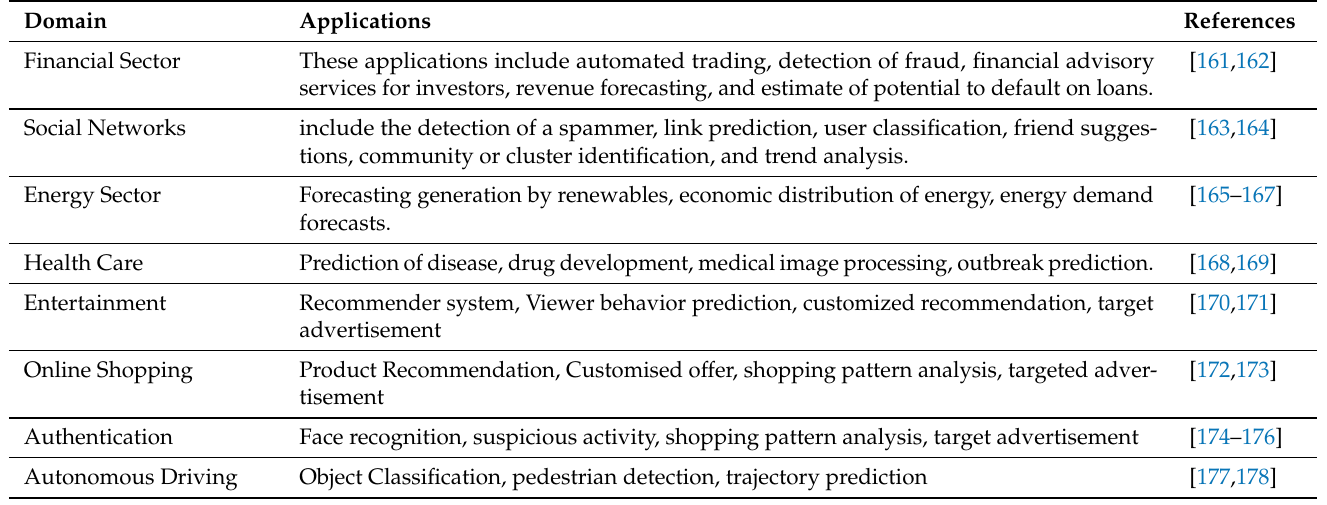
Table 4. Applications of ML in Different